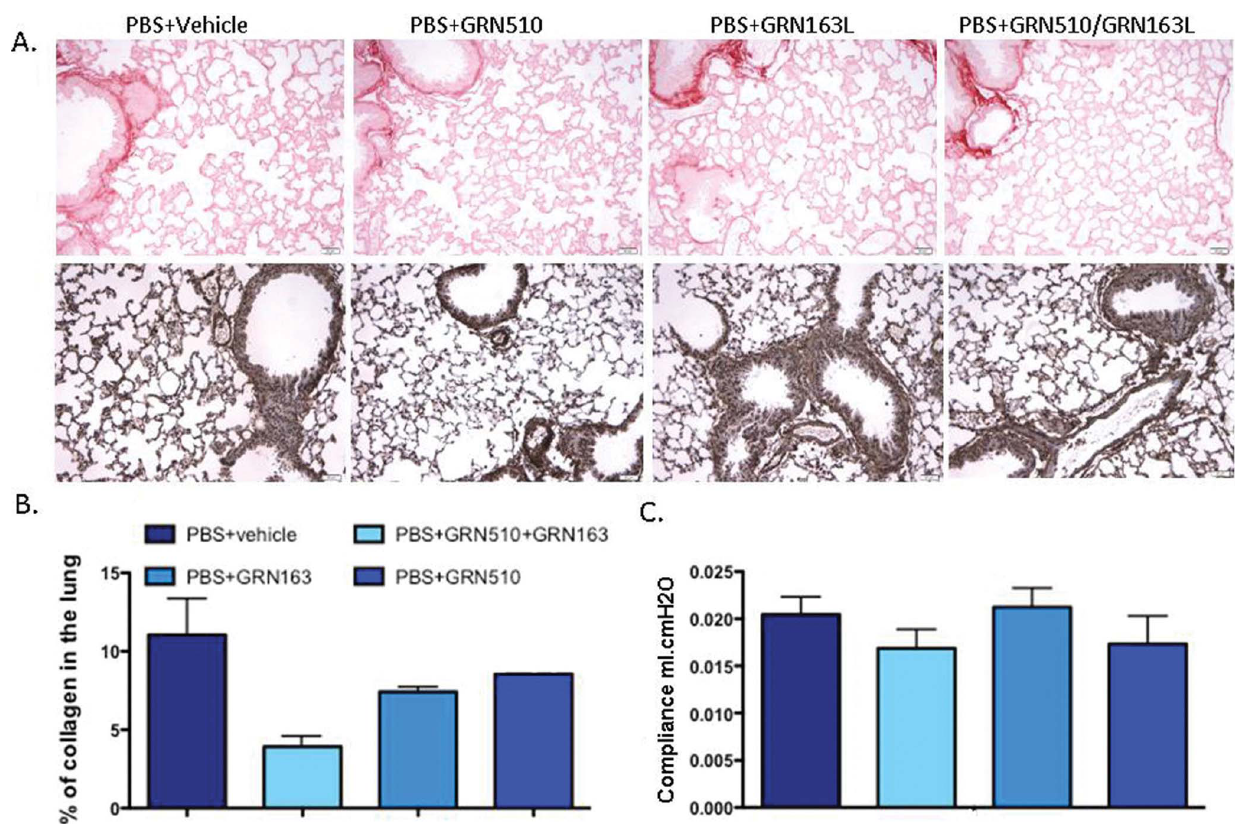
Figure 2. GRN510 and GRN163L treatments did not affect the structure and the function of the lungs. Mice were treated with GRN510, GRN163L, and GRN510 + GRN163L for 3 weeks. Expression of a -smooth muscle actin ( a SMA) and collagen deposition was evaluated as well as the baseline lung mechanics. A. Representative picorsirius red staining (upper panel) and immunostaining of a 2 SMA (lower panel) are shown; X200. B. Collagen deposition was quantified using ImagePro software by blinded personnel to the treatment groups. C. Dynamic compliance (ml/cm H2O) was measured. Treatment with the 2 components, alone or in combination indicated no difference in compliance among groups. Statistical analysis was performed by 1-way ANOVA (Prism, GraphPad Software, Inc). N=4 per group (same animals as assessed in Fig. 1E); For all plots, mean 6 SEM is shown.